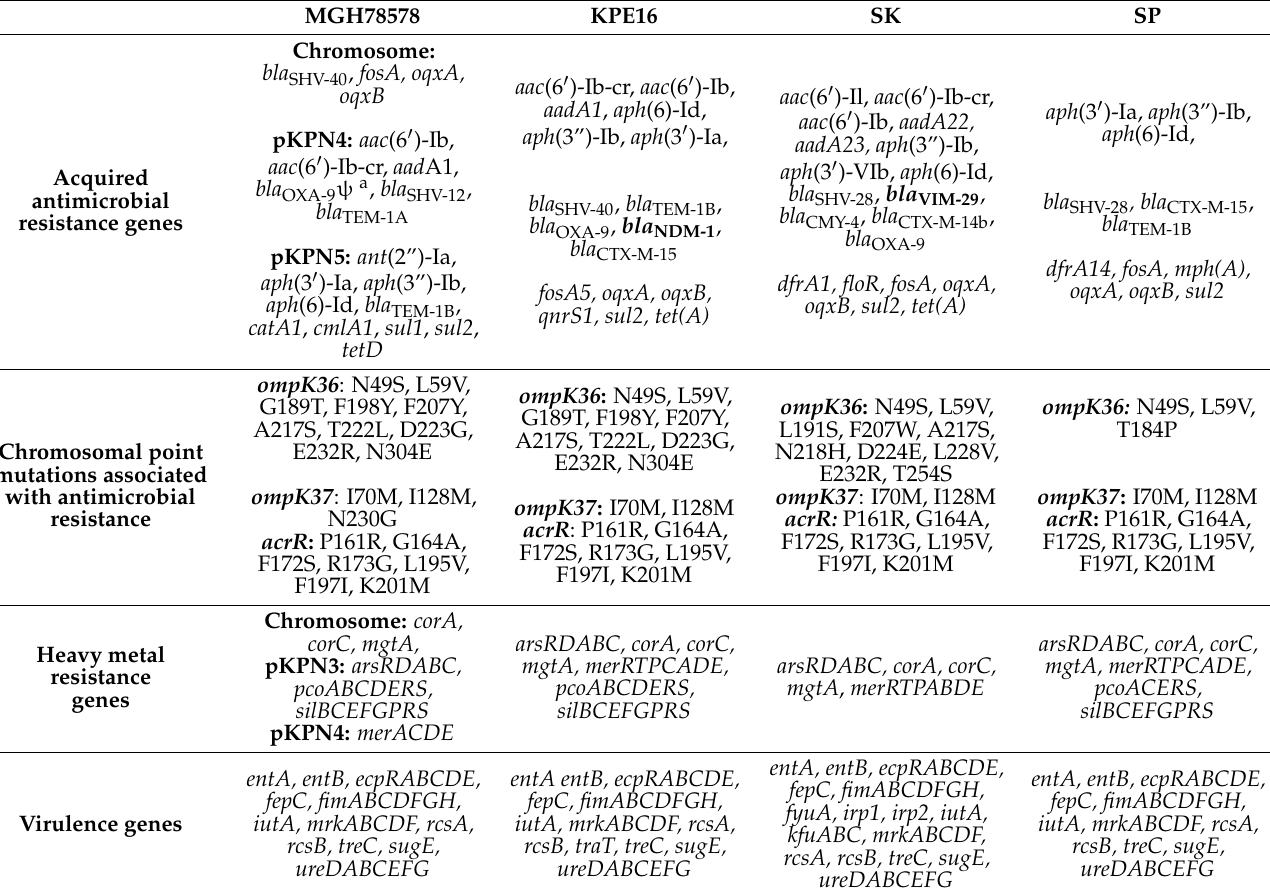
Table 3. Analysis of antimicrobial resistance, heavy metal resistance, and virulence genes carried by Egyptian K. pneumo- niae strains. MGH78578 KPE16 SK SP